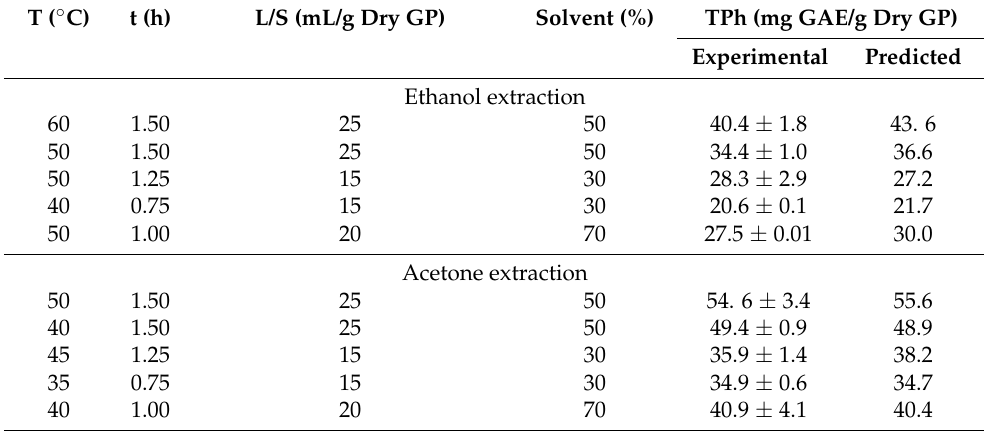
Table 2. Levels selected for each factor for the validation assays of ethanol and acetone extraction models and respective experimental (mean ± standard deviation) and predicted